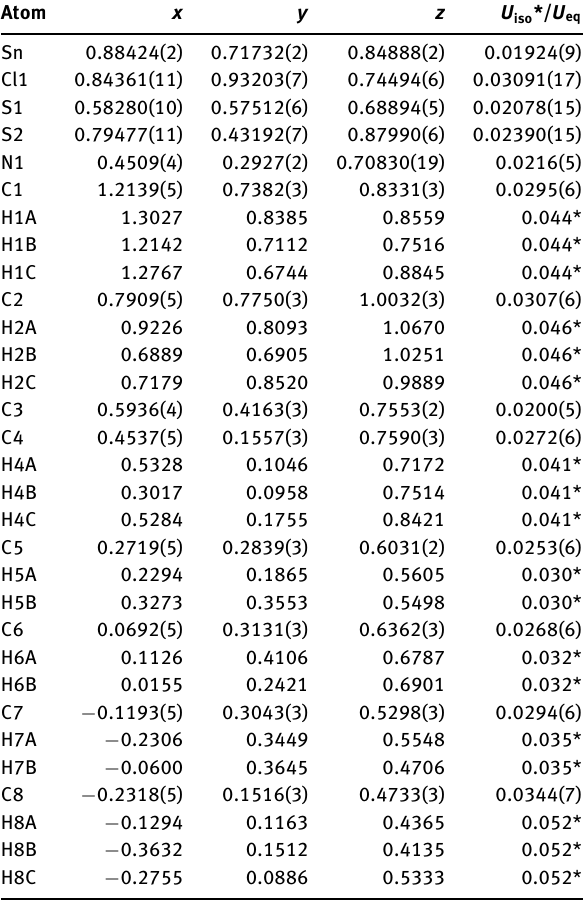
Table 2: Fractional atomic coordinates and isotropic or equivalent isotropic displacement parameters (Å 2